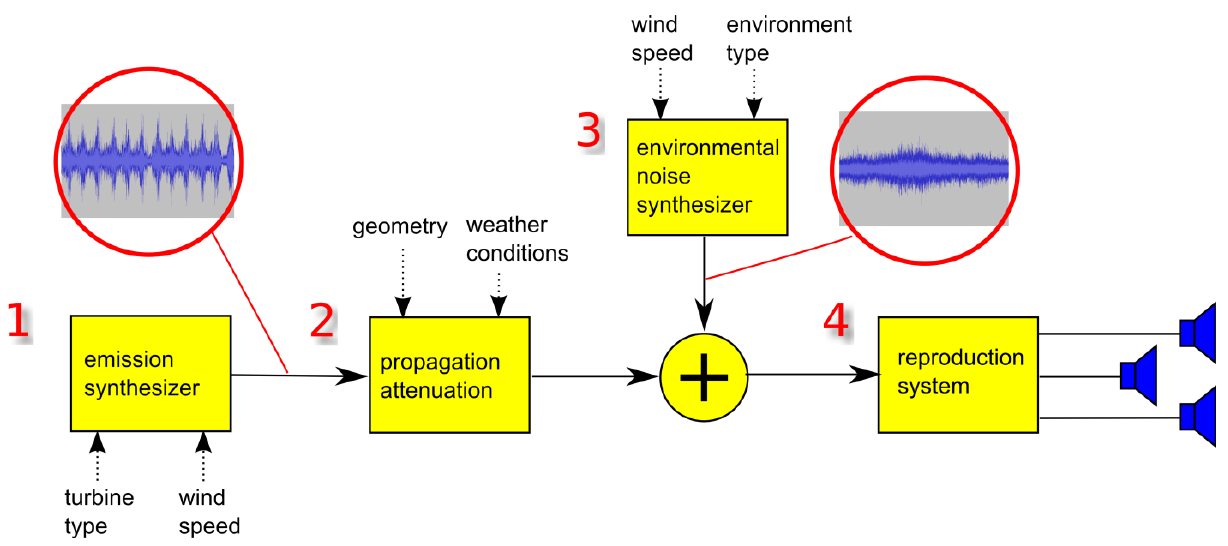
Figure 4. Block diagram for the generation of synthetic wind turbine and environmental